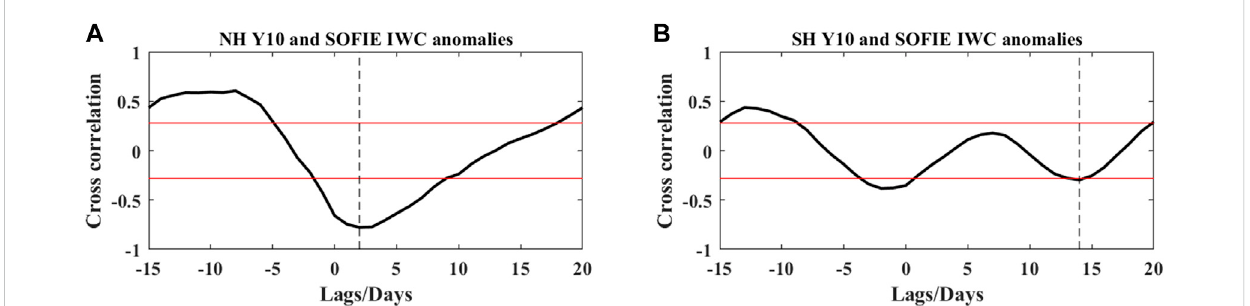
Figure 2 shows the average response of temperature anomalies from the SOFIE and MLS to solar forcing for both hemispheres. The results reveal that the time lags with statistical signi fi cance > 95% of the NH temperature response to Y10 are 2 days (based on the data from the SOFIE) and 1 day (for the MLS data set). While in the SH, the time lag days are 12 days (for SOFIE and MLS). With signi fi cant differences, the time lags in the SH are much longer than those in the NH. Figure 3 exhibitstheaverageresponseoftheIWCtosolarforcingfor the NH (left) and SH (right). The time lags in the NH are 2 days (with a statistical signi fi cance of > 95% of all days), and the timelags intheSH are 14 days. The trough in the NH is lower than that in the SH, indicating that the statistical signi fi cance is higher in the NH. Previous results have